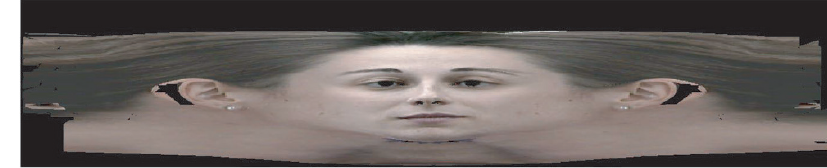
Figure 7: The texture map generated from the front and the profile view.